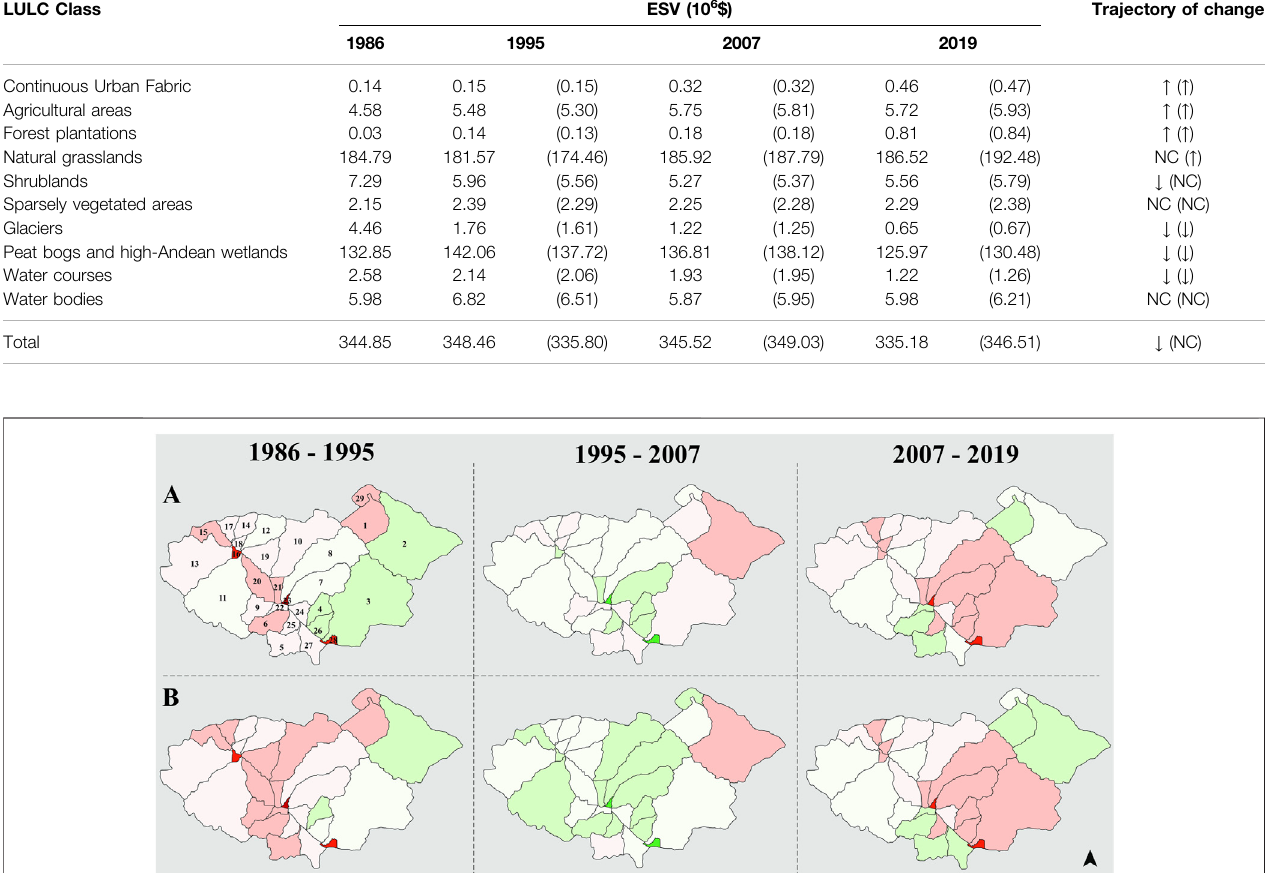
Frontiers in Environmental Science |